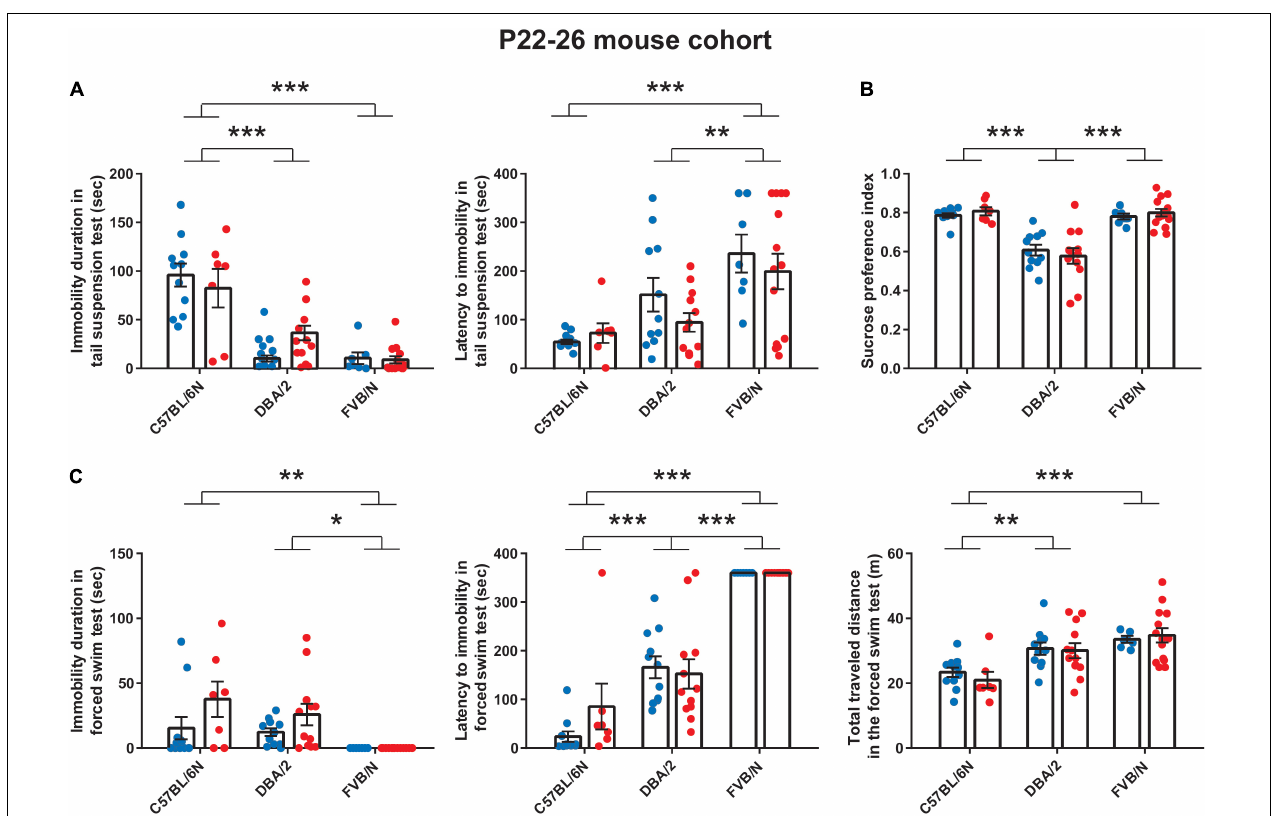
FIGURE 1 | Baseline depression-like behaviors in P22–26 mouse cohort. (A) In the tail suspension test, C57BL/6N mice showed a significant increase in the baseline immobility duration compared to both DBA/2 and FVB/N mice. Additionally, FVB/N mice showed a significant increase in the latency to first immobility compared to both C57BL/6N and DBA/2 mice. (B) In the sucrose preference test, DBA/2 mice showed a lower sucrose preference index than both C57BL/6N and FVB/N mice. (C) In the forced swim test, FVB/N mice showed lower immobility duration and increased latency to first immobility than C57BL/6N and DBA/2 mice. C57BL/6N showed a decreased total traveled distance compared to DBA/2 and FVB/N mice. In (A–C) , no sex difference was revealed within any of the aforementioned strains. Blue and red dots represent males and females, respectively. Two-way ANOVA followed by Tukey post hoc test,* p ≤ 0.05, ** p ≤ 0.01, and *** p ≤ 0.001. Error bars indicate the standard error of the mean